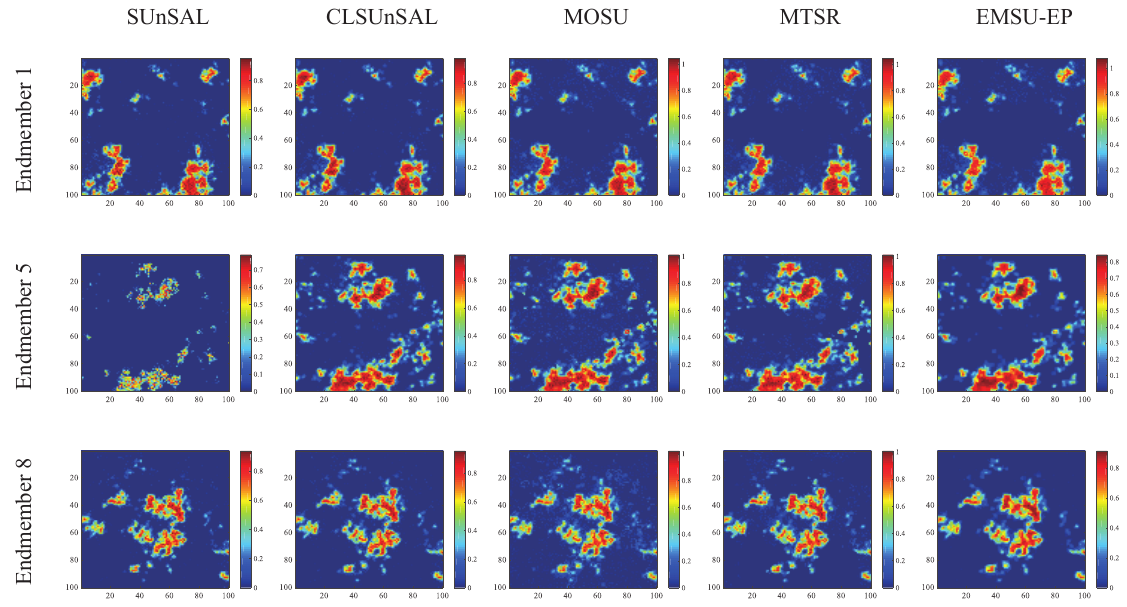
Figure 9. The estimated abundance maps of endmember 1, endmember 5 and endmember 8 for data 2 on 30 dB SNR obtained by different